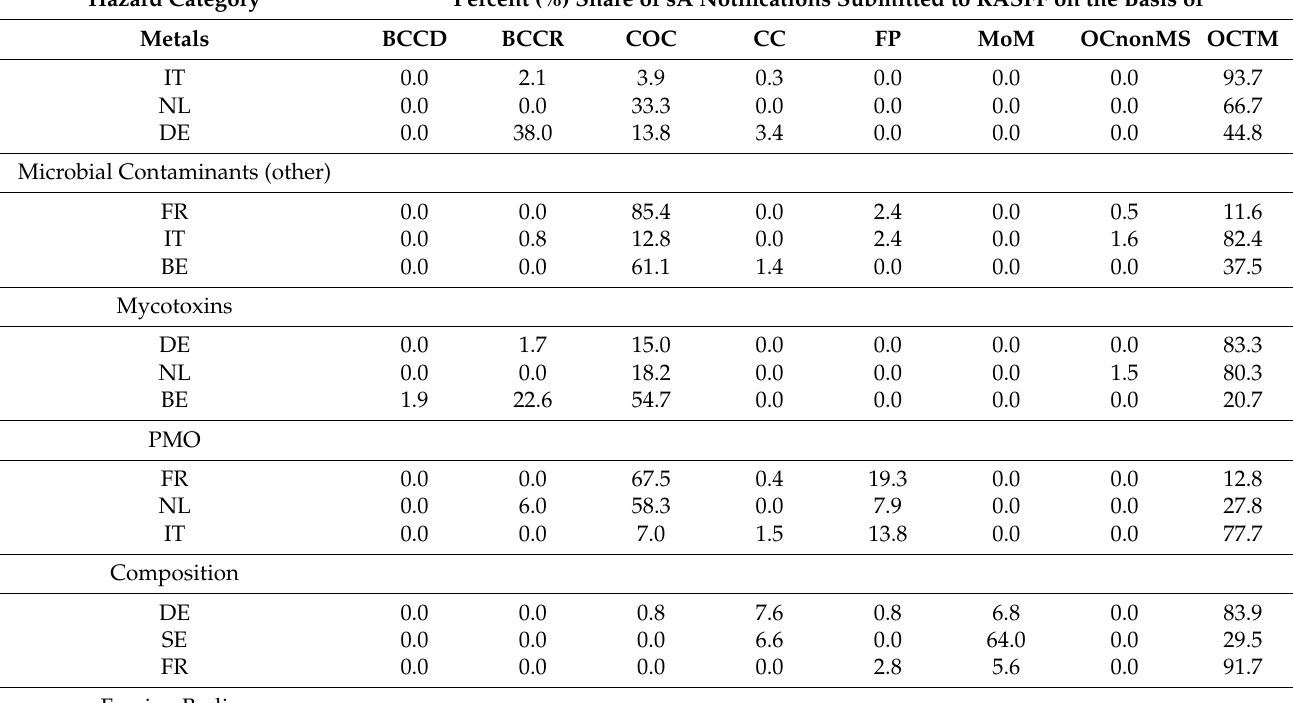
Table 5. Serious alert (sA) notifications on the seven food hazard categories (mycotoxins, microbial contaminants (other), foreign bodies, composition, allergens, metals, PMO) submitted by the top-three EU RASFF MS on the basis of BCCD, BCCR, COC, CC, FP, MoM, OCnonMS, and OCTM. Hazard